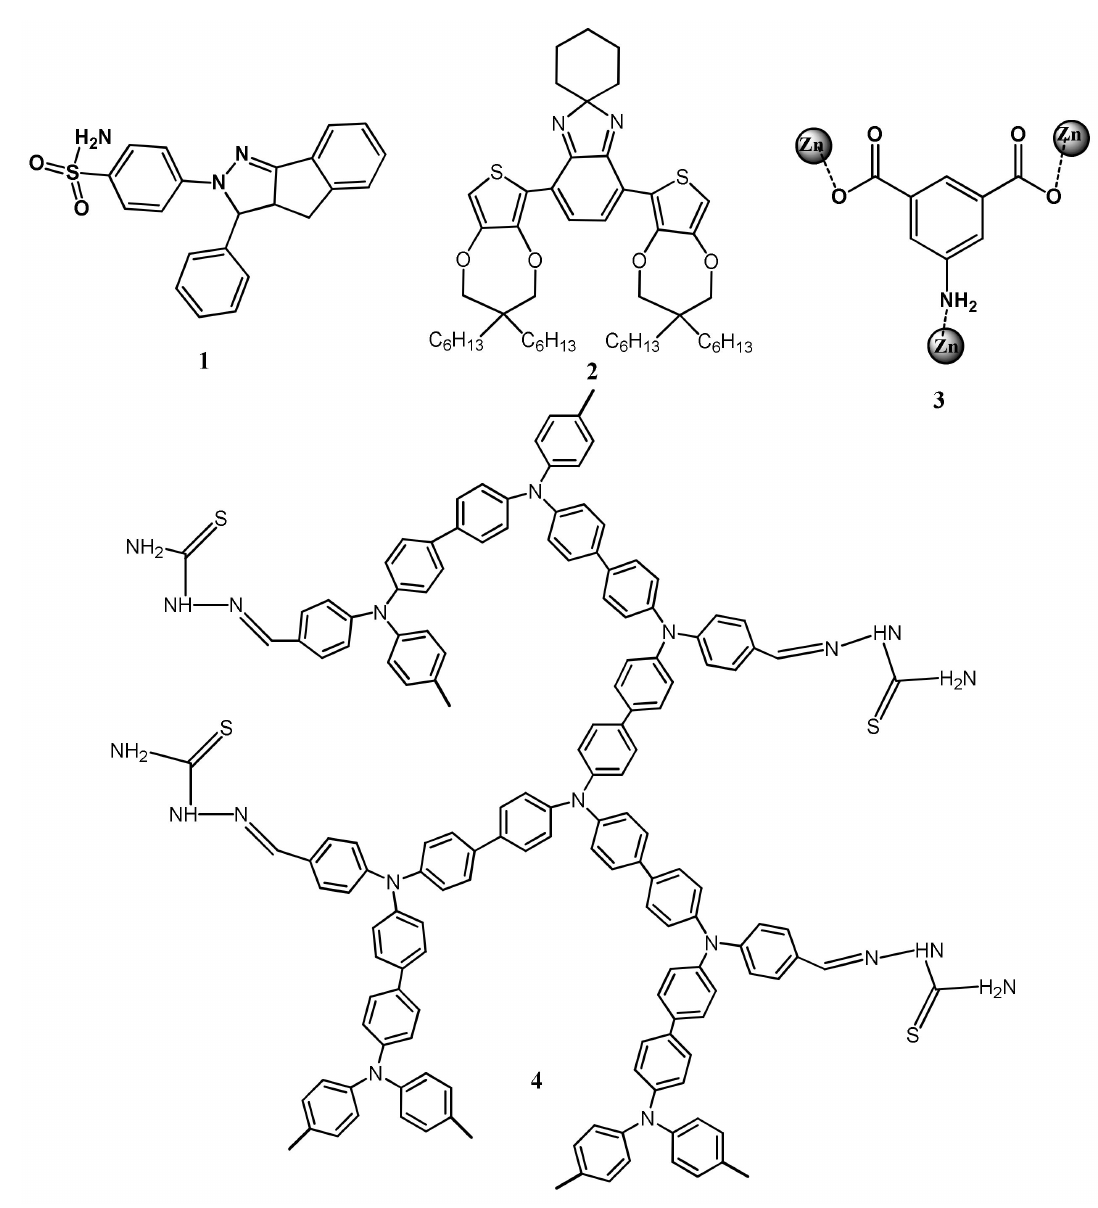
Figure 3. Molecular structures of the sensors 1 to 4